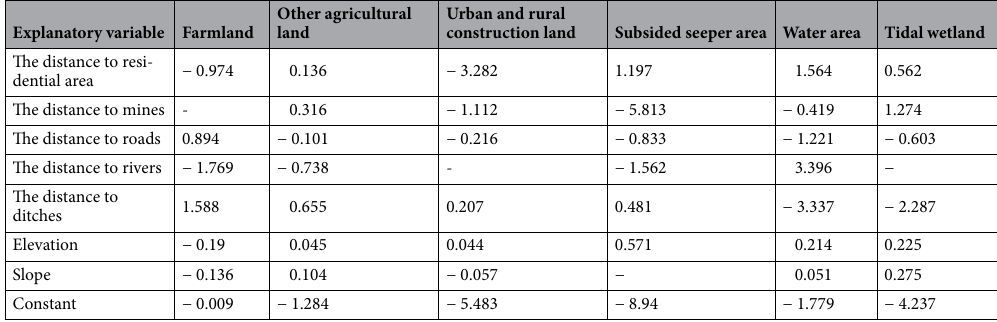
Table 4. Regression coefficient (β) of each LULC type and driving